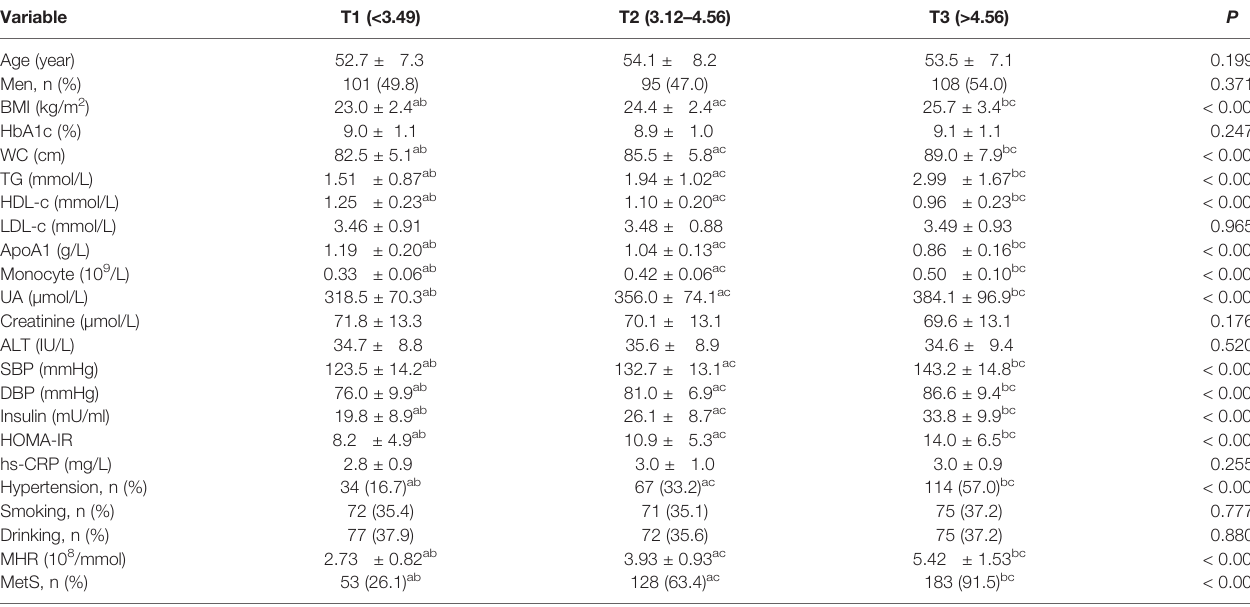
BMI, body mass index; UA, uric acid. TG, triglyceride. HDL-c, high-density lipoprotein cholesterol. LDL-c, low-density lipoprotein cholesterol. ApoA1, apolipoprotein A1.SBP, systolic bloodpressure.DBP,diastolicbloodpressure.HOMR-IR,homeostasismodelassessmentinsulinresistance.hs-CRP,high-sensitivityC-reactiveprotein.MHR,monocyte – to – HDL-cratio.